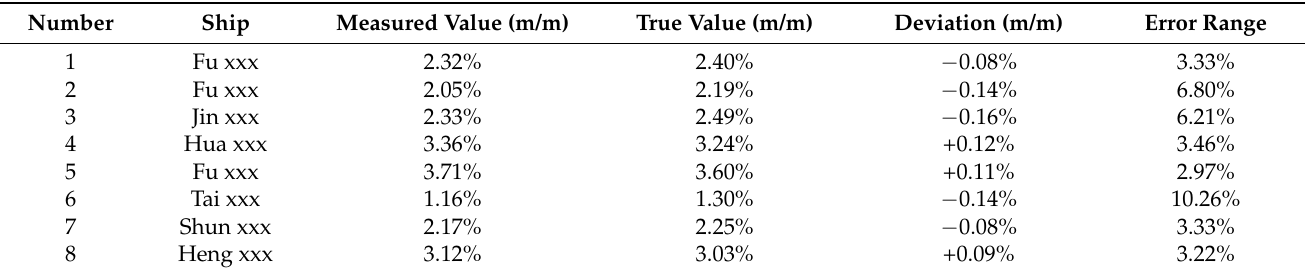
Table 3. Comparison between the true value of FSC and the measured value of FSC of 8 ships.